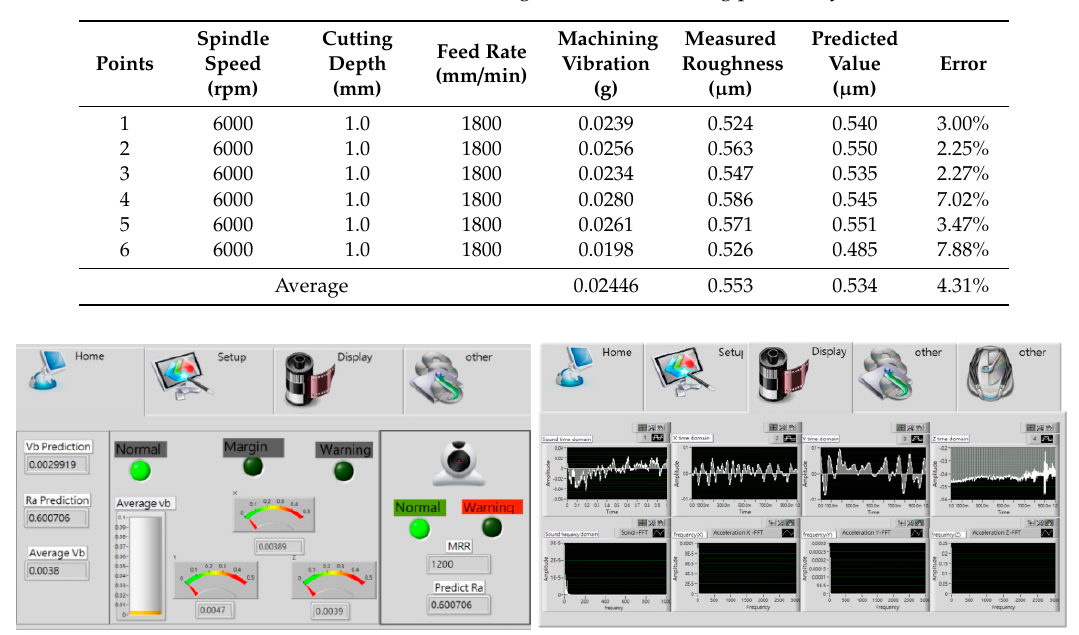
Figure 16. Monitoring system for machining vibration and prediction of surface roughness.